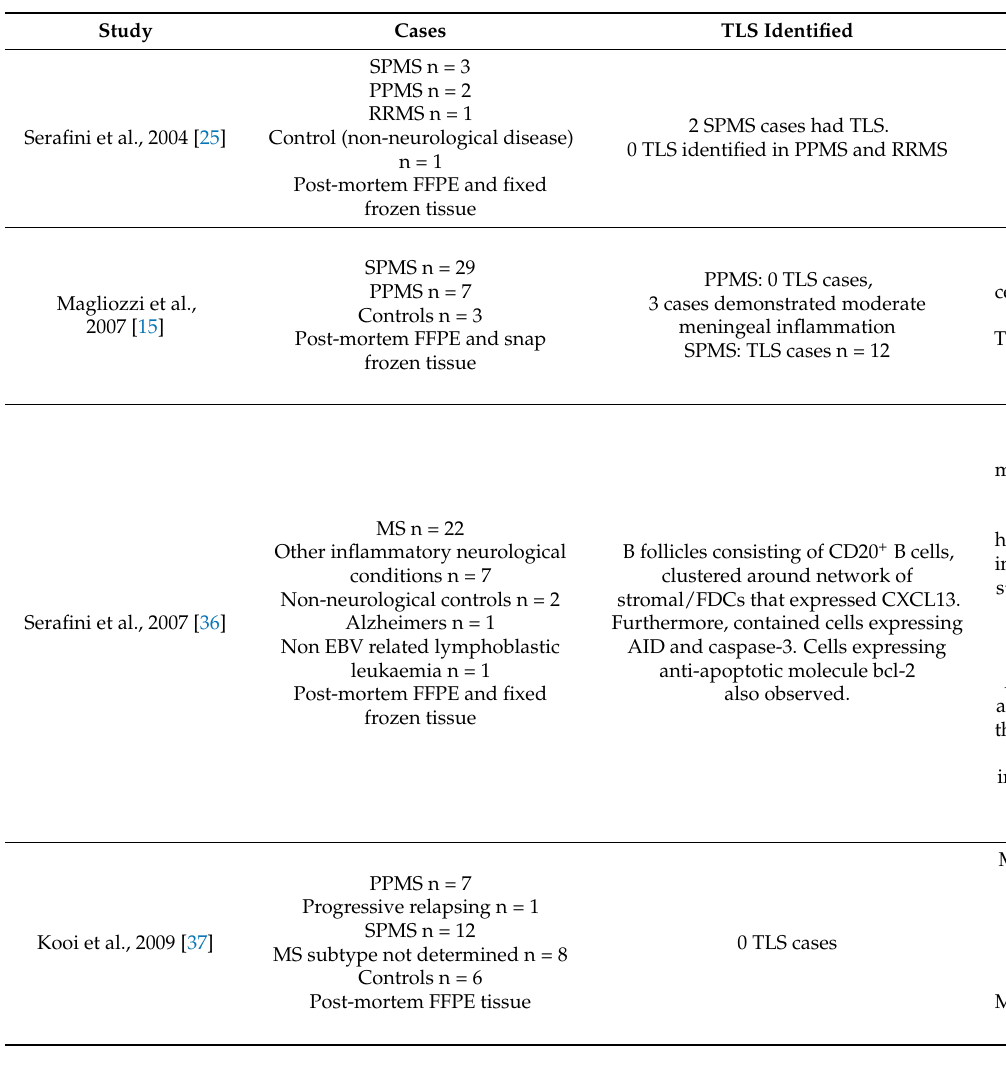
Table 1. Summary of human TLS